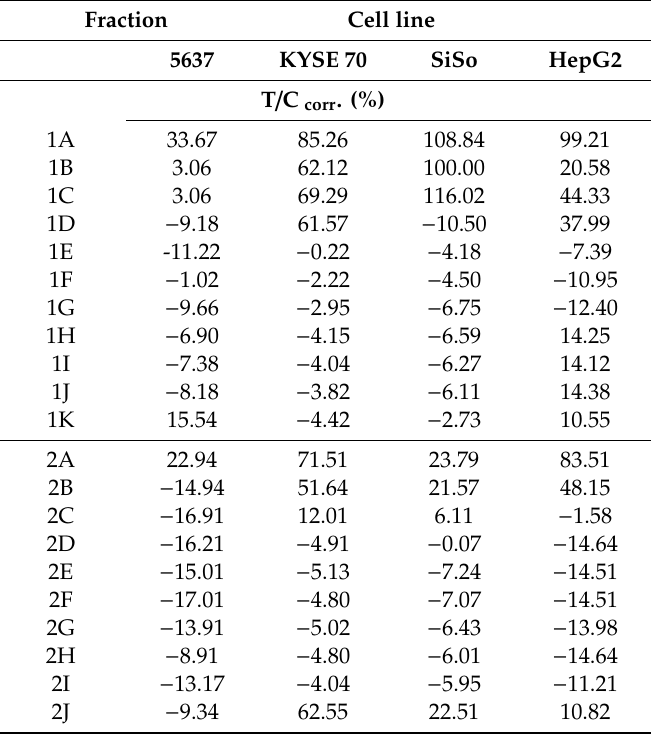
Table 6. Antiproliferative activity as T / C corr. (%) of fractions (50 µ g / mL) on 5637, KYSE 70, SiSo and HepG2 cell